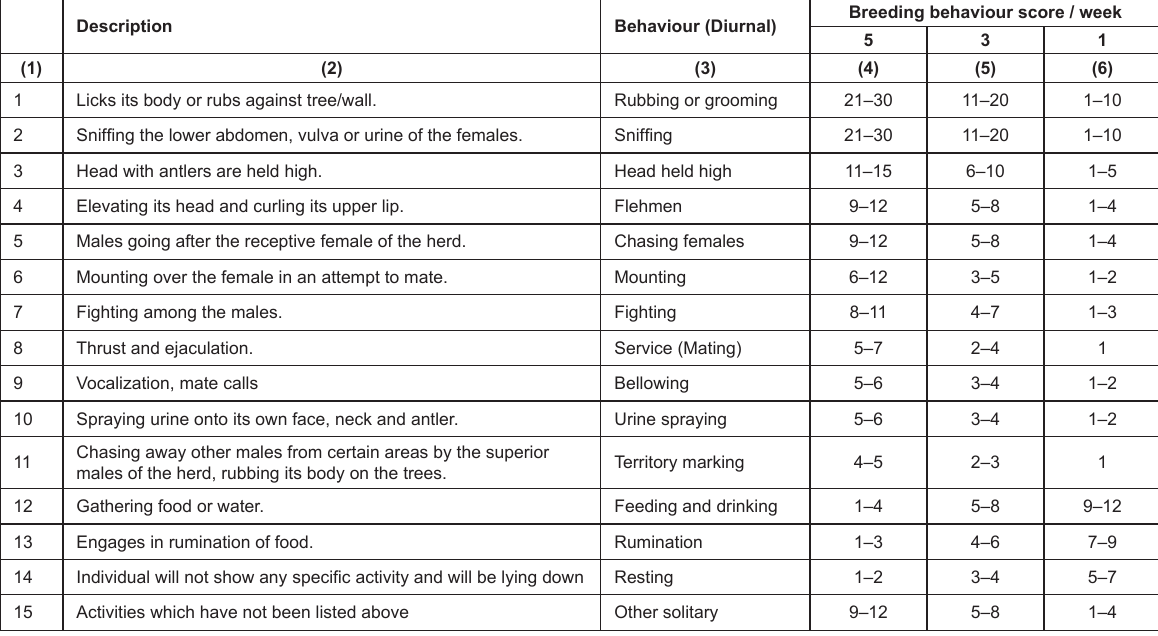
Table 1. Ethogram and score chart used for behavioural data